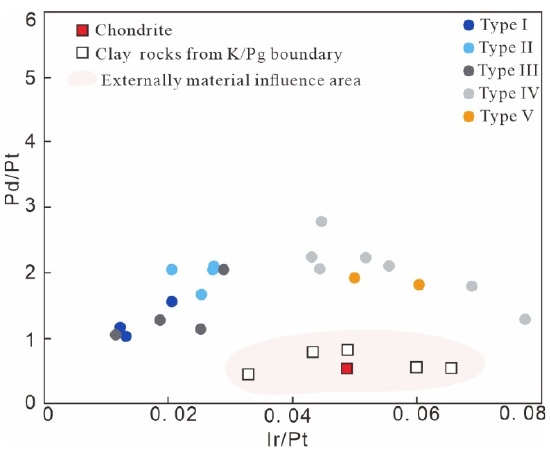
Figure 7. Ir/Pt–Pd/Pt discrimination diagram of CN outcrop